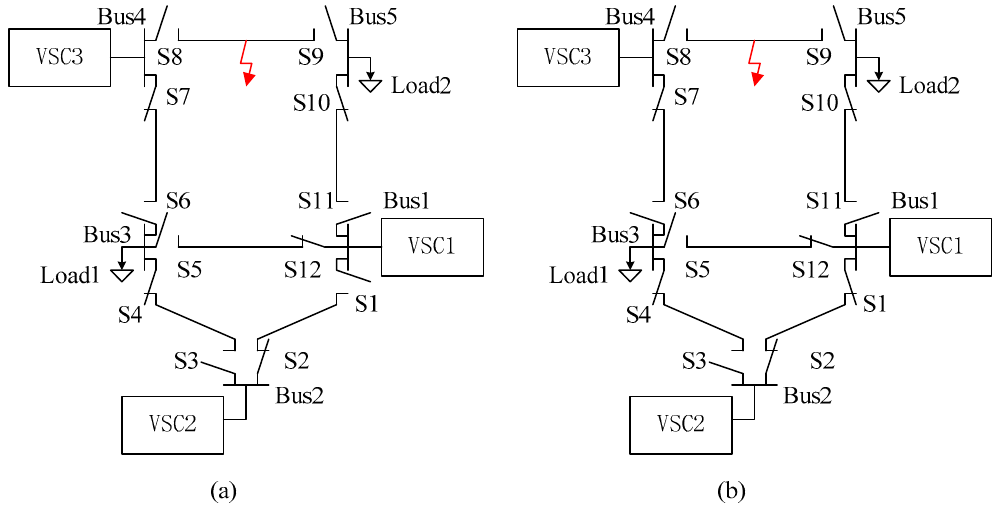
Figure 9. Switch operations of the classical handshaking method: ( a ) Switches state after step 2; ( b ) Switches state after step 4.